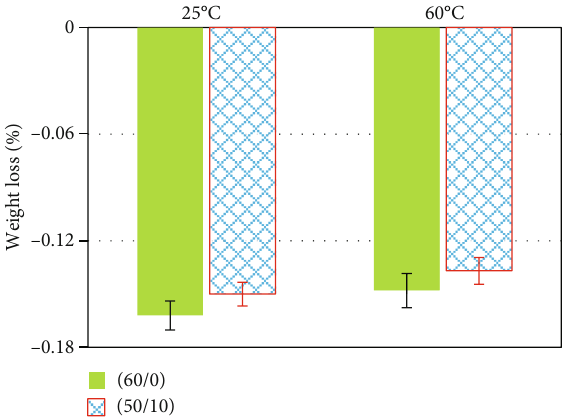
Figure 6: The e ff ect of EeRSO on migration property of PVC material.